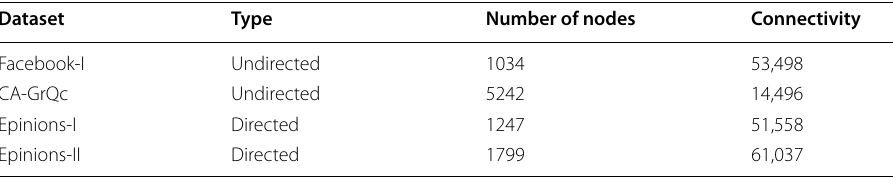
Table 2 Network dataset